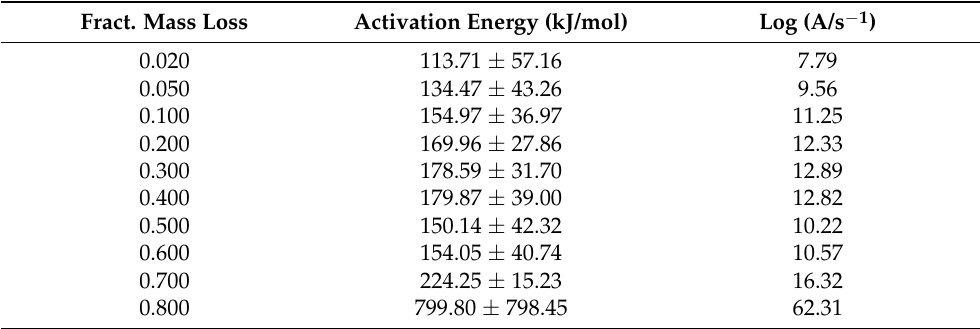
Table A1. Activation energy and pre-exponential coefficient as a function of the degree of reaction determined by the Friedman method for pine wood.